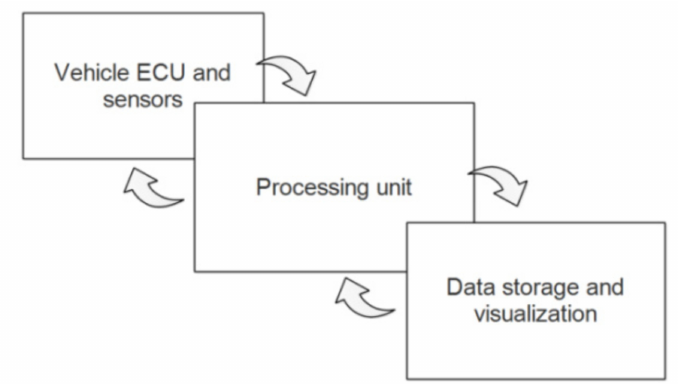
Figure 1. According to [10], all three subsystems are interconnected, and they are exchanging